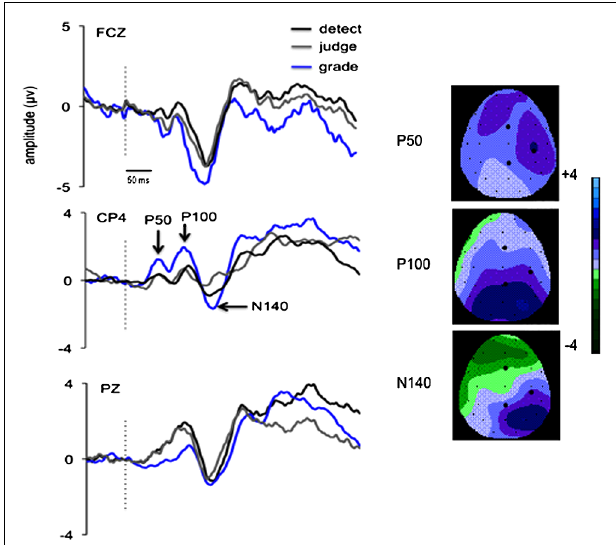
FIGURE 2 | Grand average waveforms in Experiment 1 ( n = 10) for the visual + tactile (VT) attended condition with the three response criteria: detect the presence of the crossmodal stimuli (black trace), judge which stimulus in the pair would require a larger response (grey trace) and grade the amplitude of the response dependent on the summed amplitudes required for the visual and tactile target stimuli (blue trace). ERPs are shown at FCZ (top), CP4 (middle), and PZ (bottom) electrode sites. ERP components of interest are labeled on the trace for electrode site CP4, indicating the latency and topographical distribution of each component.Voltage topographs over the 32 channels are shown for a 30 ms window centered around the peak for the P50, P100, and N140 components for theVT stimuli.The larger black dots represent FCZ (top), CP4 (right), and PZ (bottom).The dotted vertical line represents the time of stimulus delivery.